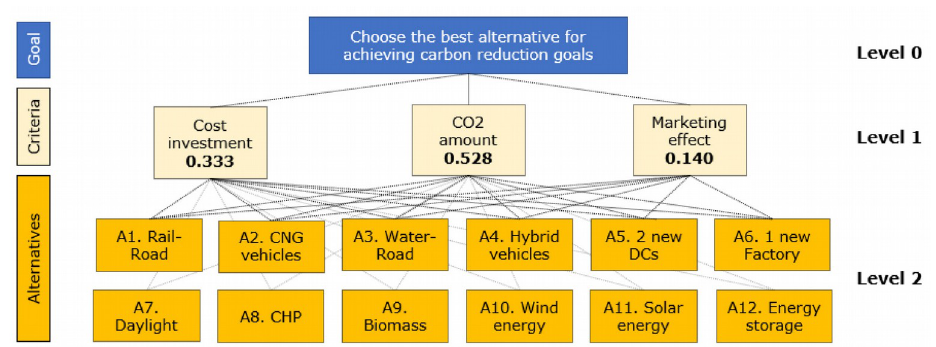
Figure 5. AHP applied to the case